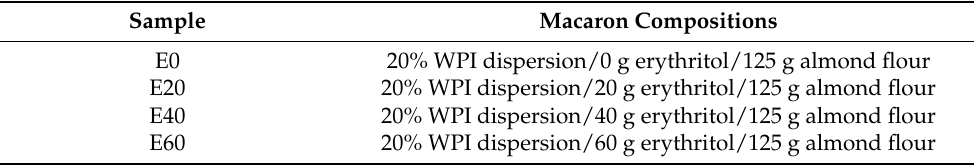
Table 1. The sample codes and composition of the obtained